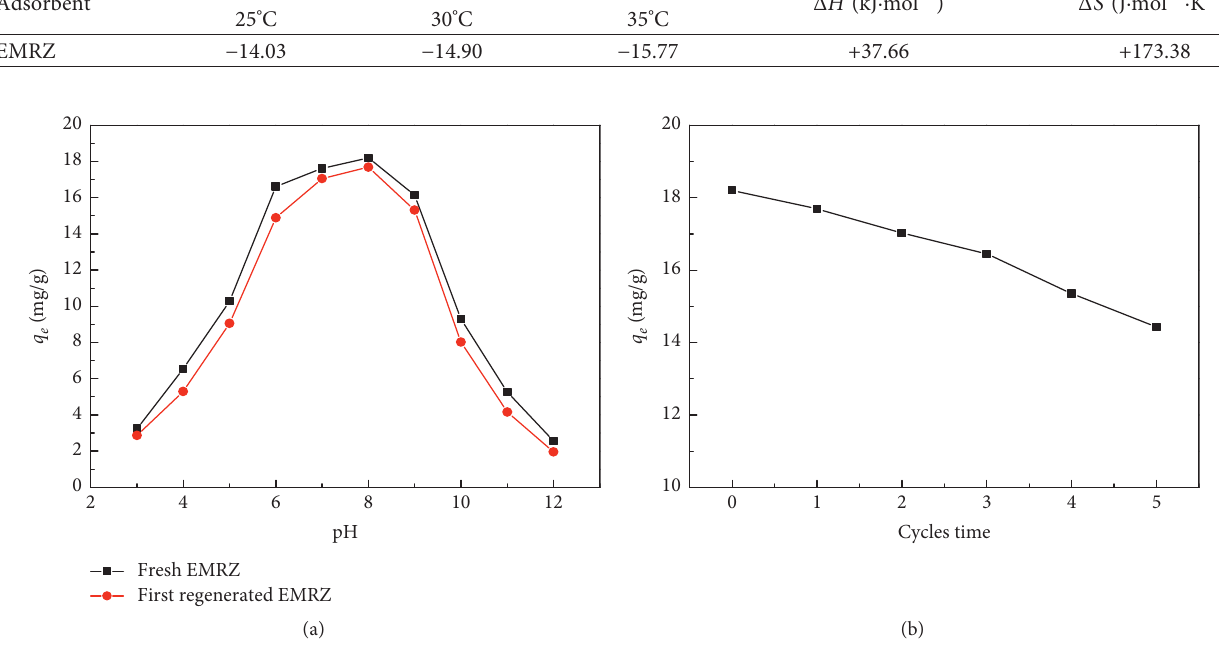
Table 4: Thermodynamic parameters for the adsorption of ammonium onto EMRZ. Adsorbent